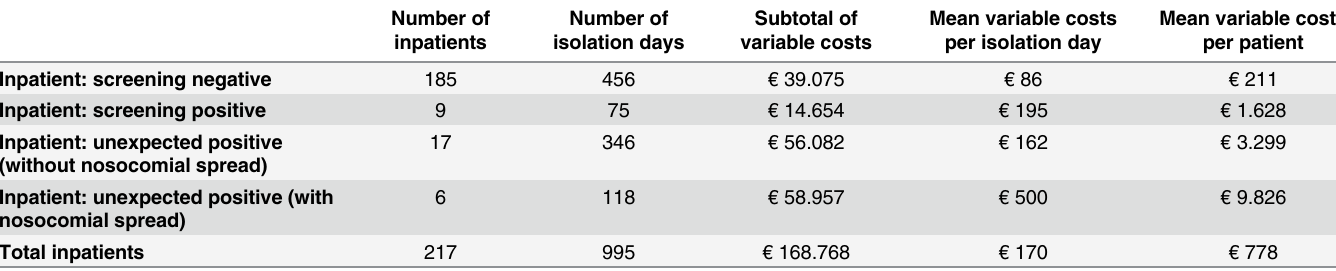
Table 5. Costs per category of